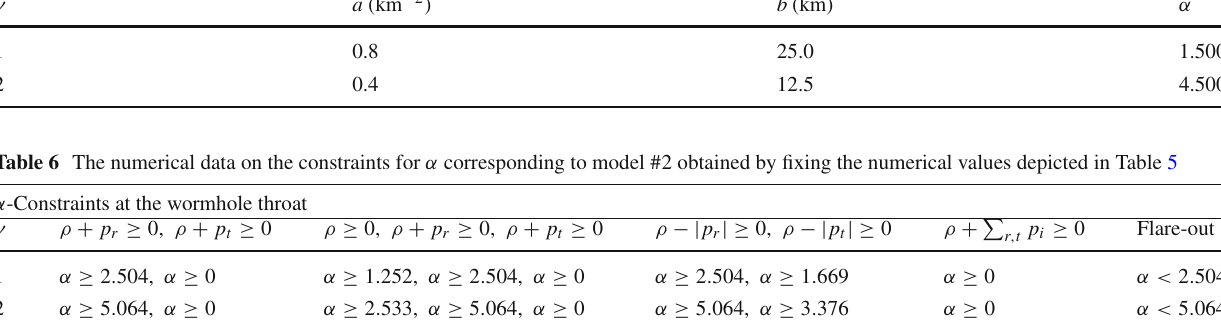
Table 5 The selected numerical values for the coupling α for some values of γ , a and b , and considering the wormhole throat r 0 = 1 ( km ) γ a ( km − 2 )